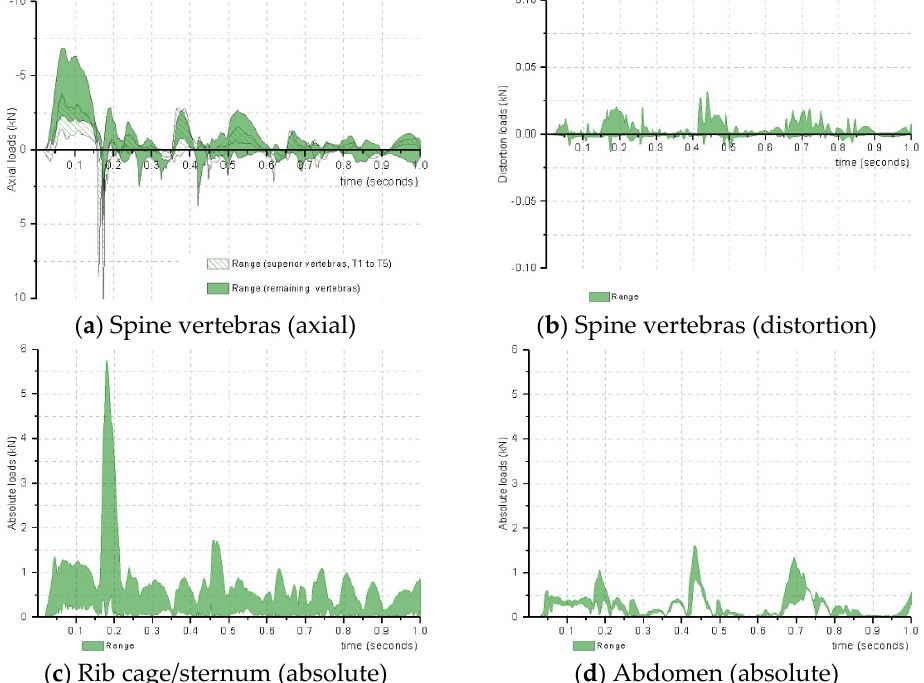
Figure 14. Internal forces in the human chest (situation 2).